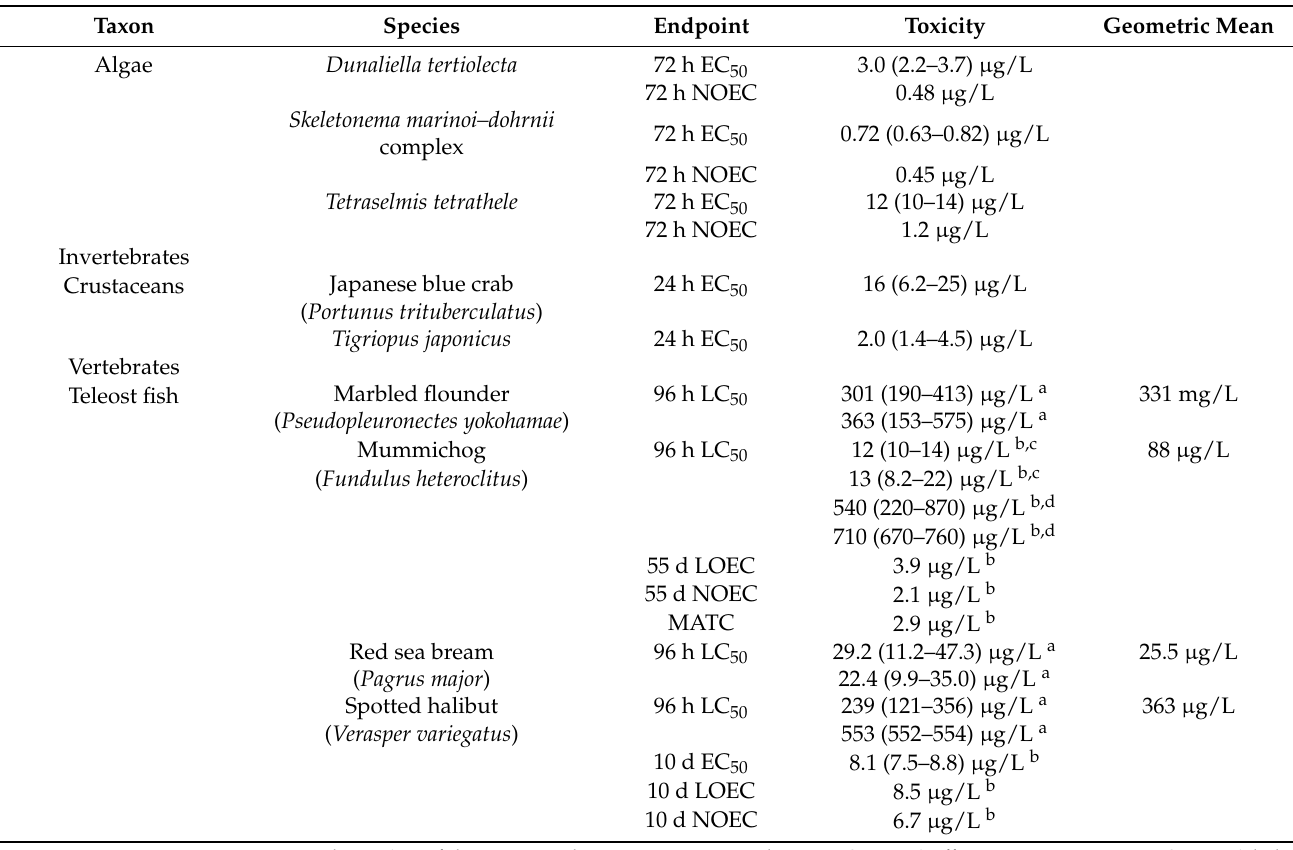
Table 4. Toxicity of polycarbamate (PC) to various marine organisms, including algal species, crustaceans, and teleosts, calculated by performing species sensitivity distribution analysis.